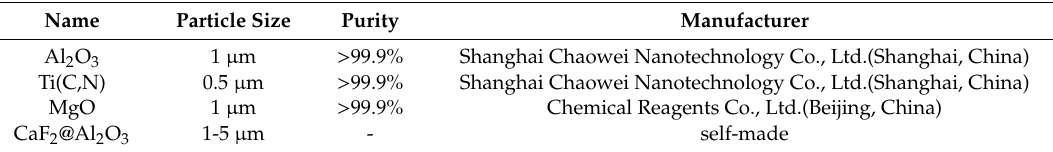
Table 1. Main materials for preparing ceramic tool materials.